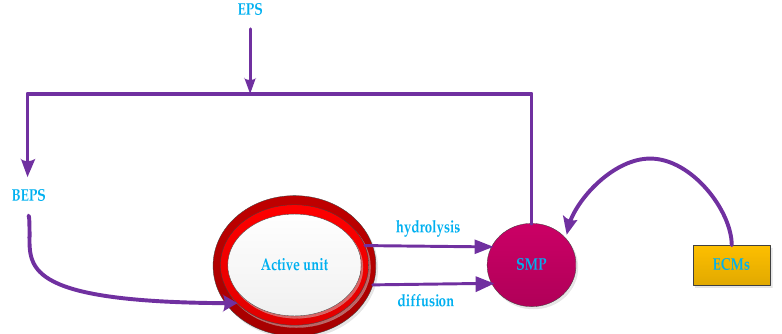
Figure 7. The relationship between EPS (extracellular polymers), BEPS (fixed EPS), SMP (soluble microbial product) active units and ECMs.